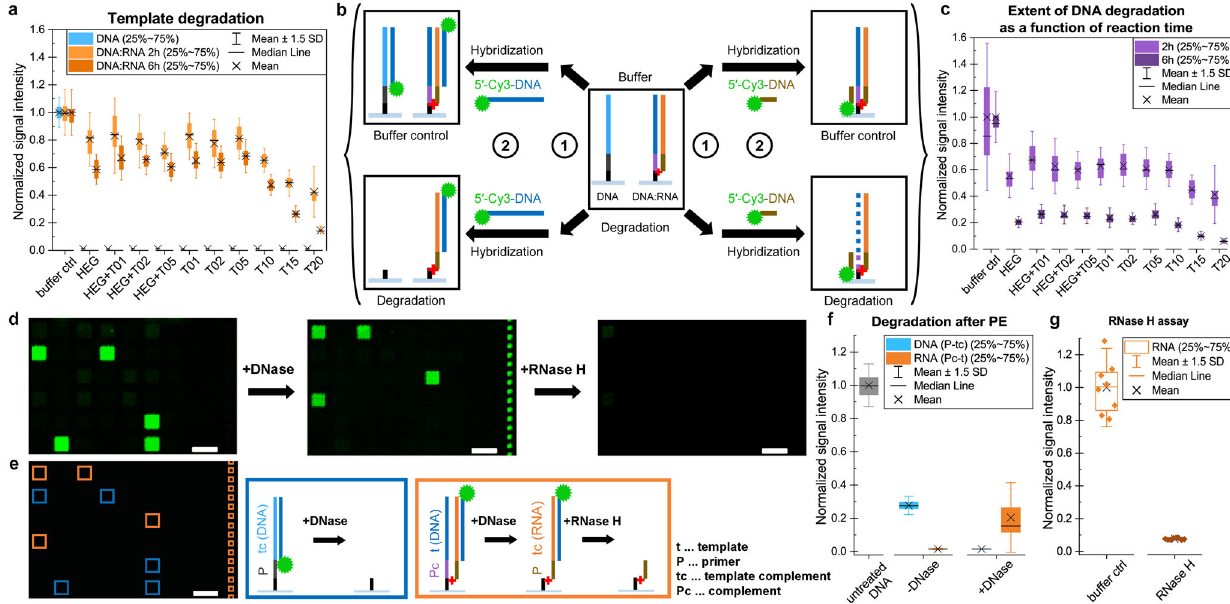
Fig. 2 Optimization of enzymatic RNA microarray synthesis. a DNA template degradation was assessed by mimicking successful primer extension and hybridizing either to DNA (blue) or to RNA crosslinked to template strands (orange) on different linkers after DNase treatment (24 replicates). A signal decrease for hybridization to RNA indicates degradation of the DNA linker. Fluorescence intensities are normalized to a buffer-treated control. b Schematic representation of the enzymatic tests performed in 2a and 2c. The microarray consists of two oligonucleotide systems: one DNA control and an RNA probe photocrosslinked to a DNA sequence. Subsections of the microarray are then either treated with buffer or degraded with DNase (step ① ), followed by hybridization to a complementary strand (step ② ): either to the RNA sequence (with the blue Cy3-labeled probe, assay 2a) or to the primer complement sequence (with the brown Cy3-labeled probe, assay 2c). c Extent of DNA template degradation as a function of treatment time with DNase for 2 h (light purple) or 6 h (dark purple) measured by hybridizing to the primer complement section of the template (24 replicates). d Excerpts of an RNA microarray hybridized before and after DNase and RNase H treatments. Scale bars are 100 µ m. Feature identity is illustrated in ( e ) with blue squares corresponding to non-transcribed DNA template complement sequence (tc) disappearing after DNase treatment and orange squares populated with transcribed DNA template sequences (t), resulting in RNA product with the template complement (tc) sequence, available for hybridization after template degradation. The resulting DNA-RNA hybrid can then be recognized and processed by RNase H, leading to RNA degradation and the corresponding RNA features disappearing from the microarray scan. f Signal intensities recorded for hybridization to DNA or RNA at various stages of the enzymatic primer extension (PE) process, the blue bars correspond to non-transcribed DNA (blue features in ( e )) and orange bars to RNA (orange features in ( e )) (62 replicates). PE ef fi ciency can be measured relative to the intensity of hybridization to ssDNA primer-template complement (P-tc) sequences on an untreated DNA microarray (gray bar). g Signal intensities recorded for hybridization to ssRNA without and with RNase H treatment (8 replicates). Source data are provided as a Source Data fi (LNA) 41 or 2 ′ -deoxy-2 ′ - fl uoro-RNA (2 ′ -F-RNA) 42 may provide similar protection while increasing selectivity. The photo-